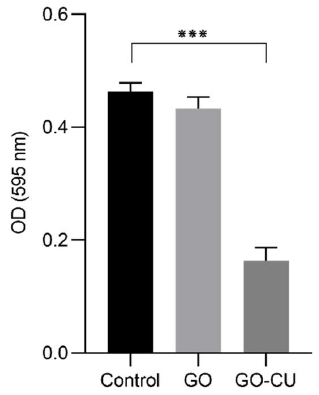
Figure 6. CV quantification of biofilm formation after 24 h on plastic, GO, and GO/CU. Biofilm biomass was stained with crystal violet, and then absorbance was read at 595 nm. Standard deviations of three independent experiments are represented by error bars. p values < 0.05 were considered significant: *** < 0.001.